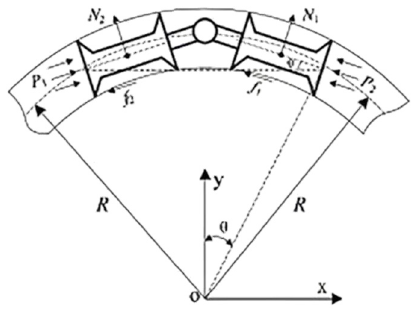
Figure 1. Force diagram of the two-section robot.